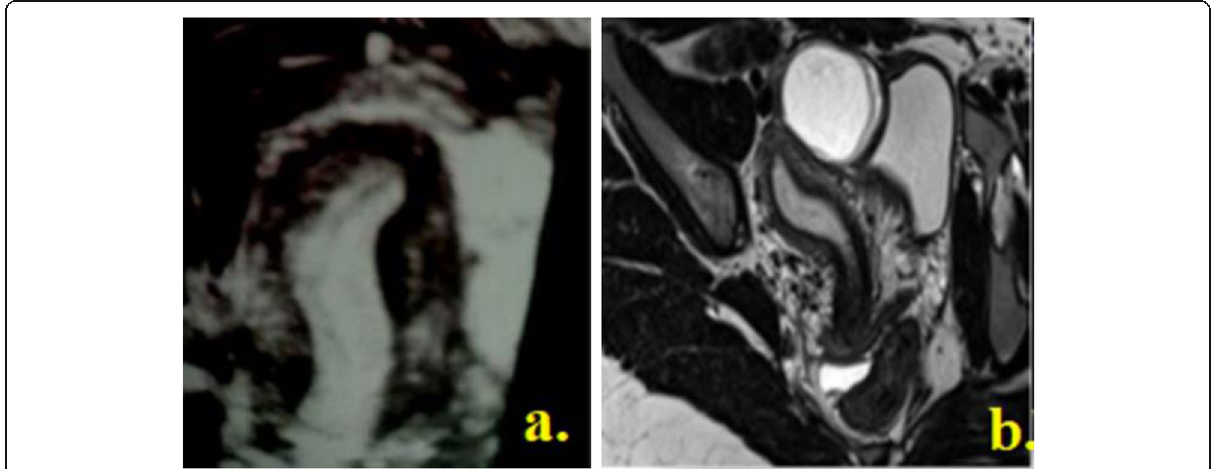
Fig. 11 An 18-year-old married female patient, complaining of infertility. a Unicoruate uterus, no functional rudimentary horn (class U4a). By 3D TV, it showed banana-shaped uterine cavity. b MRI coronal T2 showing banana-shaped uterine cavity and small functional ovarian cyst, with no rudimentary cavity